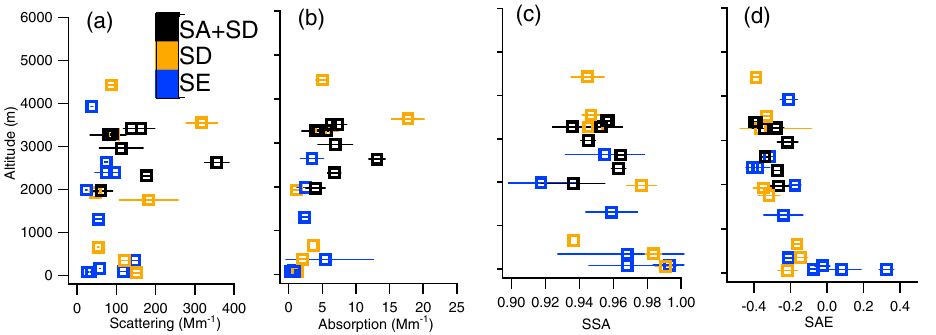
Figure 13. The optical properties ( d < 2.5µm) for all SLRs: (a) total scattering (Mm − 1 ); (b) absorption (Mm − 1 ); (c) SSA at λ = 500nm; (d) SAE ( λ = 450–700nm). The markers show the mean value of each SLR with bars indicating 1 σ variability.